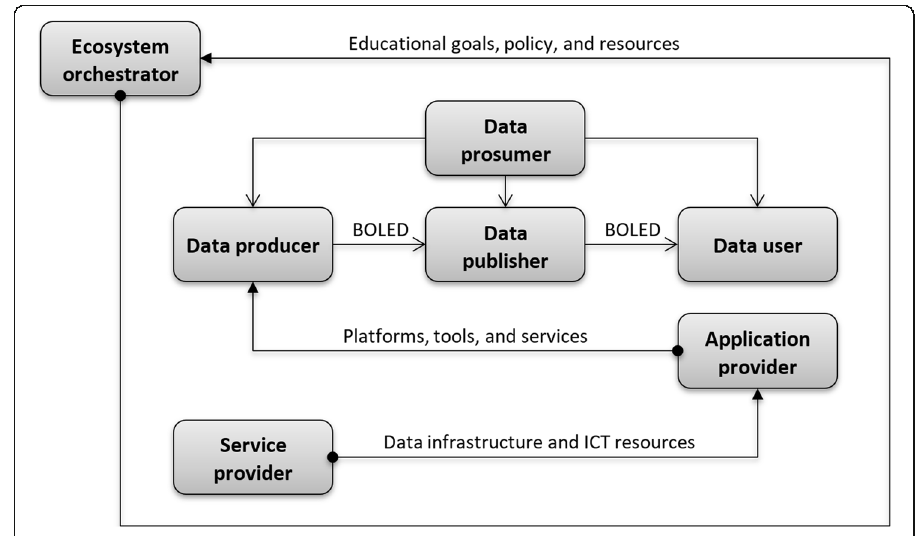
Fig. 4 The emerging roles in the BOLED analytics ecosystem. Source: Ln ě ni č ka and Komárková (2019)